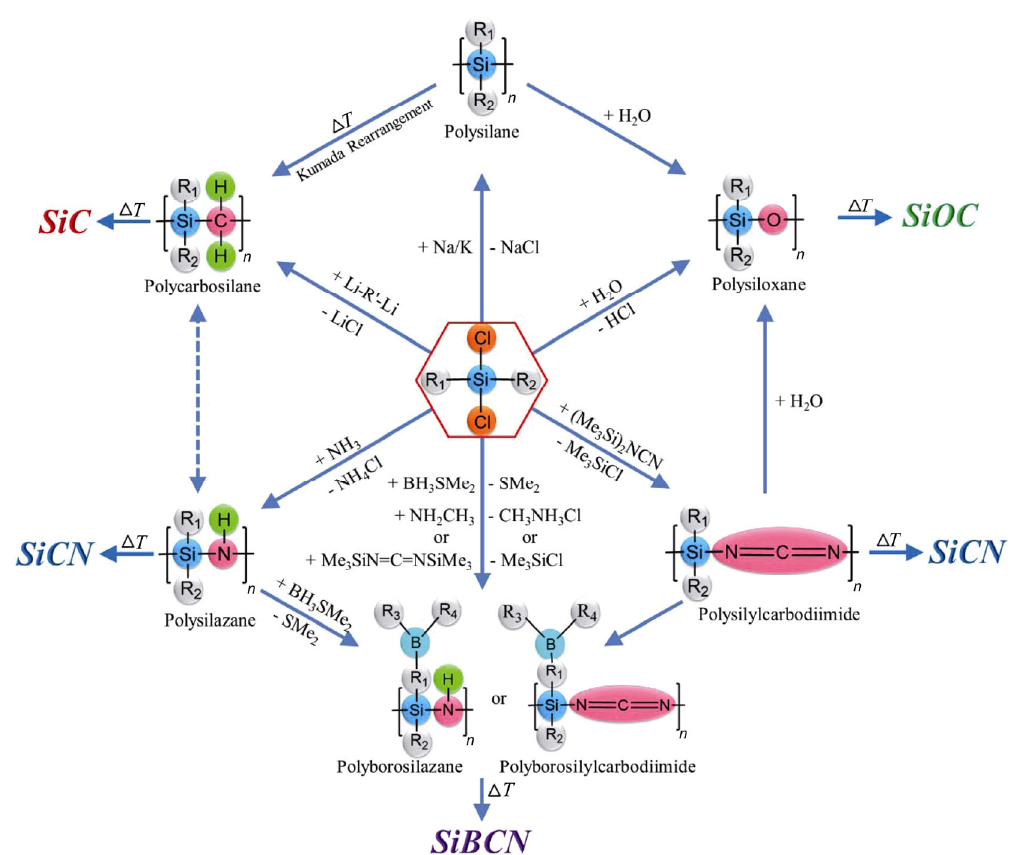
Fig. 2 Synthetic routes for typical Si-based polymers and associated ceramics from organochlorosilanes. R 1 –R 4 represent organic groups or hydrogen attached to silicon of the polymer backbone. Reproduced with permission from Ref. [36], © Elsevier Ltd.